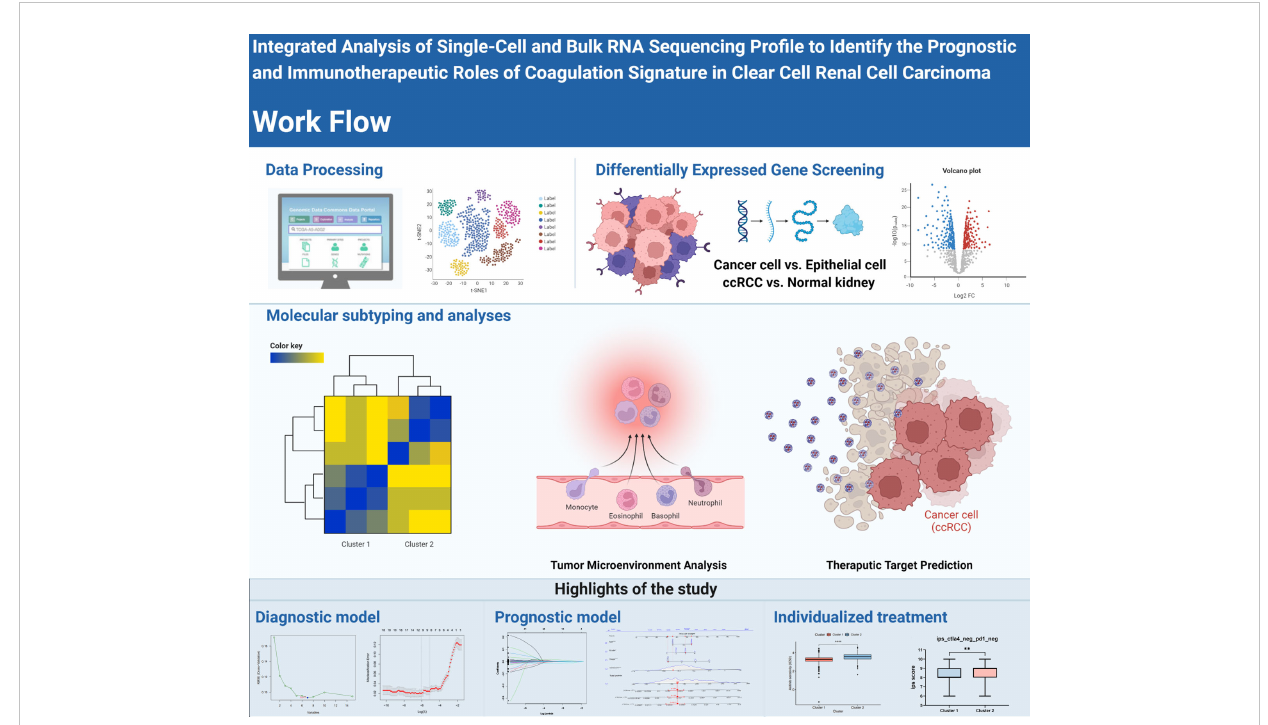
FIGURE 1 The graphical outline diagram of the whole process of this study. GP style: *: p< 0.05; **: p < 0.01; ***:p<0.001; ****